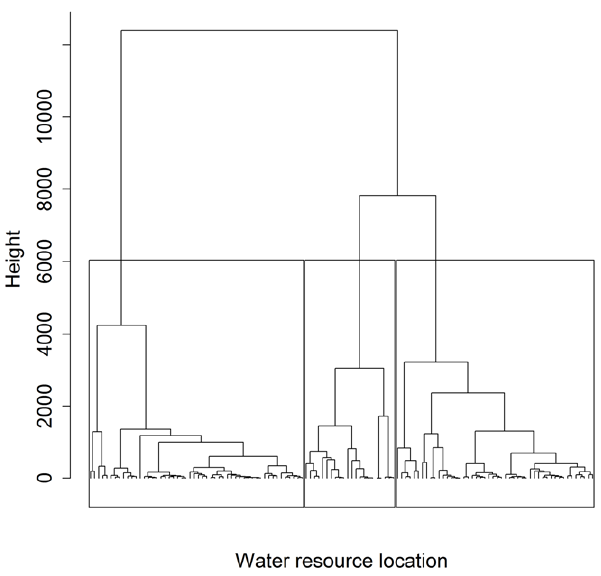
Figure 2. Three-group dendrogram showing average cluster- ing of Cartesian locations of water sources (permanent water ponds and horse-excavated wells, n =122) on Sable Island, Canada, 2008–2010. Boxes separate groups; each node represents a single location of a water source. The height of lines connecting water sources represents the distance between groupings. The left-most box contains sources located in area 2; the centre box contains sources located in area 1; the right-most box contains sources in area 3.